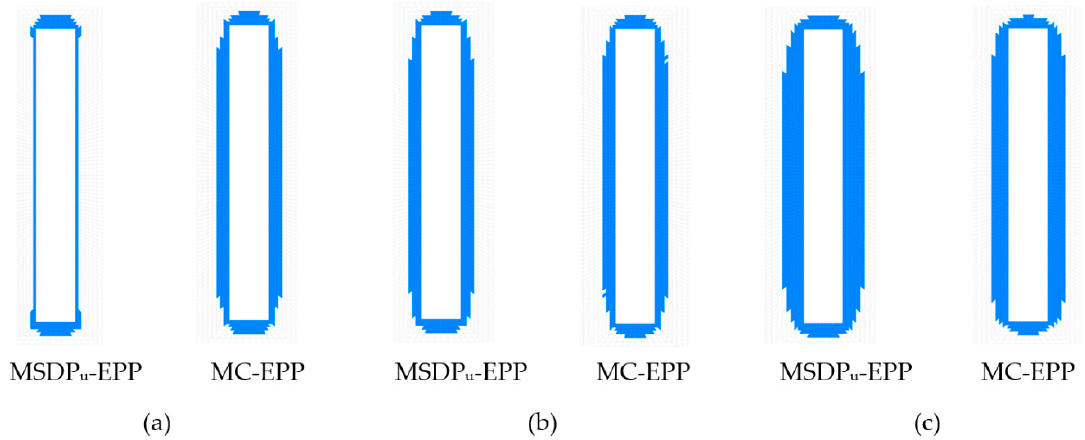
Figure 13. Yielded areas around the stope along a vertical cross cut section in the xz symmetric plane, obtained from the numerical simulations with the MSDP u -EPP and MC-EPP models, respectively, considering ( a ) σ h = σ v , ( b ) σ h = 1.4 σ v and ( c ) σ h = 2 σ v.